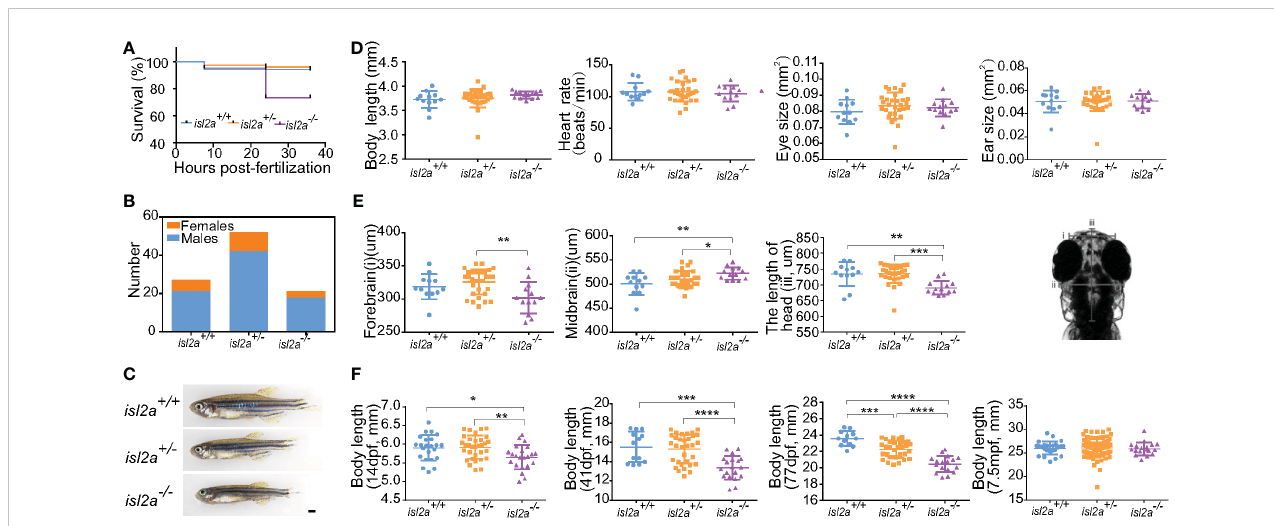
FIGURE 4 Growth retardation in isl2a knockout zebra fi sh. (A) The Kaplan-Meier survival curve of isl2a +/+ (n = 159), isl2a +/ − (n = 173), and isl2a − / − (n = 253) larvae shows differences. (B) Male/female ratios in isl2a +/+ (male/female = 20/6), isl2a +/ − (male/female = 42/10), and isl2a − / − (male/female = 18/3). (C) The isl2a variant caused signi fi cant growth defects in 41 dpf zebra fi sh adults. Scale bar = 1 mm. (D) Comparison of developmental indicators, including body length, heart rate, eye size, and ear size, among isl2a -/- , isl2a +/+ and isl2a +/- siblings at 5 dpf. (E) Comparison of three diameter lines of skull among different groups at 5 dpf. (F) Dynamic tracking of the body length of isl2a -/- individuals and their isl2a +/+ and isl2a +/- siblings at 14 dpf, 41 dpf, 77 dpf, and 7.5 mpf. *P<0.05, **P<0.01, ***P<0.001,